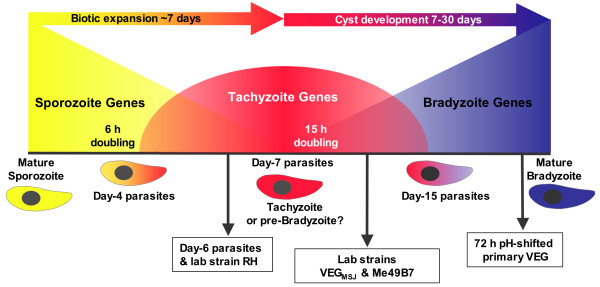
Summary of the gene expression patterns associated with sporozoite-initiated development. The relative timeline of sporozoite to bradyzoite development is indicated at the top of the diagram. Sporozoite- and bradyzoite-specific gene expression clearly demarcates these stages, while tachyzoite-specific patterns are more fluid with respect to developmental phenotypes. Gene expression patterns in Day-6 and RH parasites are highly correlated; however, the maximum tachyzoite antigen expression based on overall SAGE tag frequencies was observed in the Day-7 population. All laboratory strains are placed in the timeline on the basis of a best-fit criterion. Alkaline-shifted parasites (pH-shifted) express all the known bradyzoite genes, and are therefore considered to be nearly identical to mature bradyzoites in this diagram.